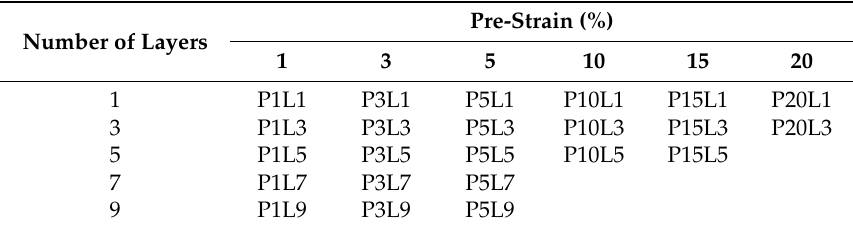
Table 1. Corrugated PEDOT:PSS conductive thin film specimens are named based on the amount of applied pre-strain and the number of layers. Pre-Strain (%) Number of Layers 1